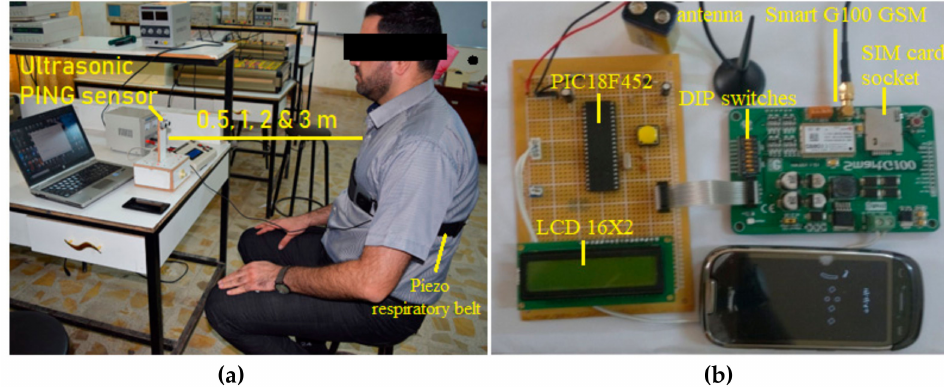
Figure 1. Materials and methods ( a ) the experimental setup; ( b ) the annotated photograph of the proposed monitoring